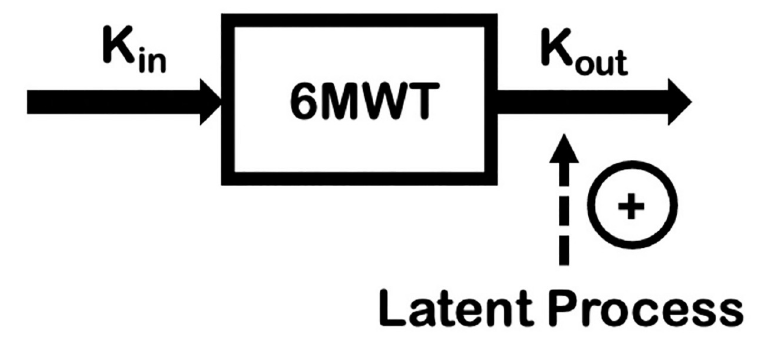
Fig 2. A schematic of the disease progression for DMD using the 6MWT developed by Lennie et al. [19]. An indirect response model was developed simultaneously for healthy subject and DMD patient natural history data of the 6MWT. A latent process model described the effect of DMD on the